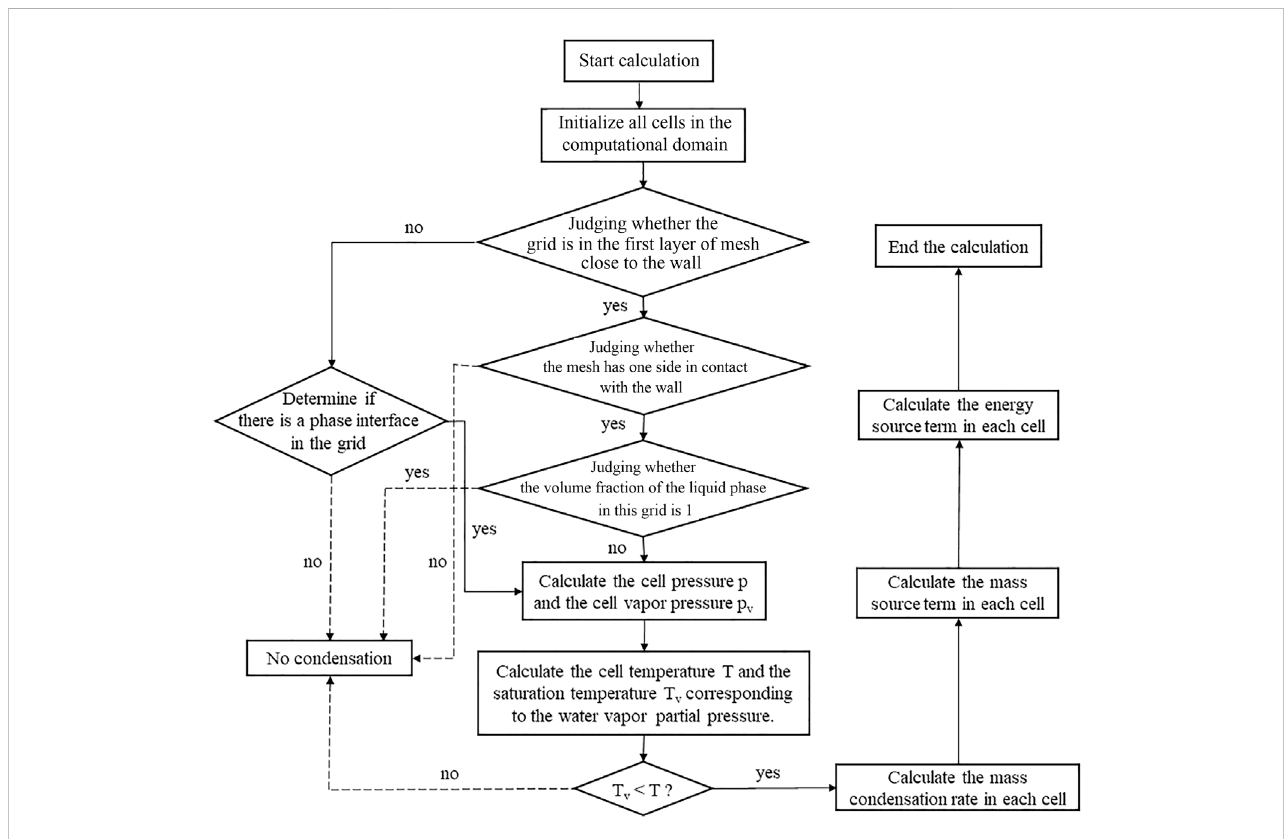
FIGURE 2 Schematic diagram of the computing program in